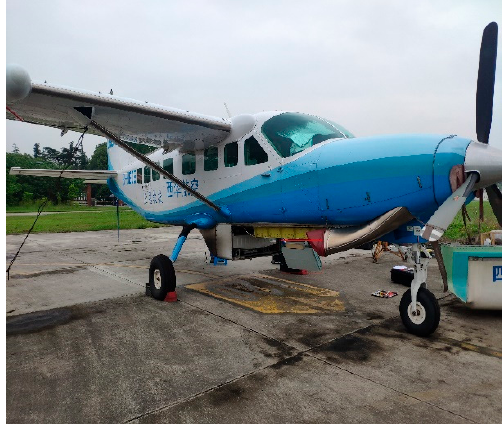
Figure 5. X/P − SAR system installed on Cessna 208.